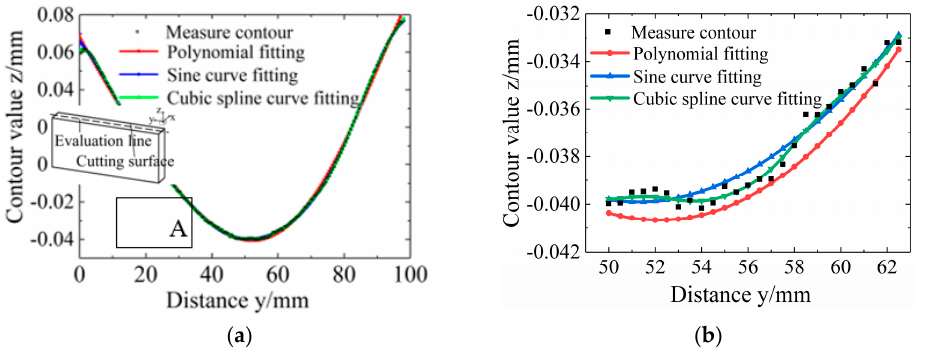
Figure 4. Fitted contour comparison of specimens. ( a ) Fitted contour comparison . ( b ) Amplifier of area A in Figure 4a.